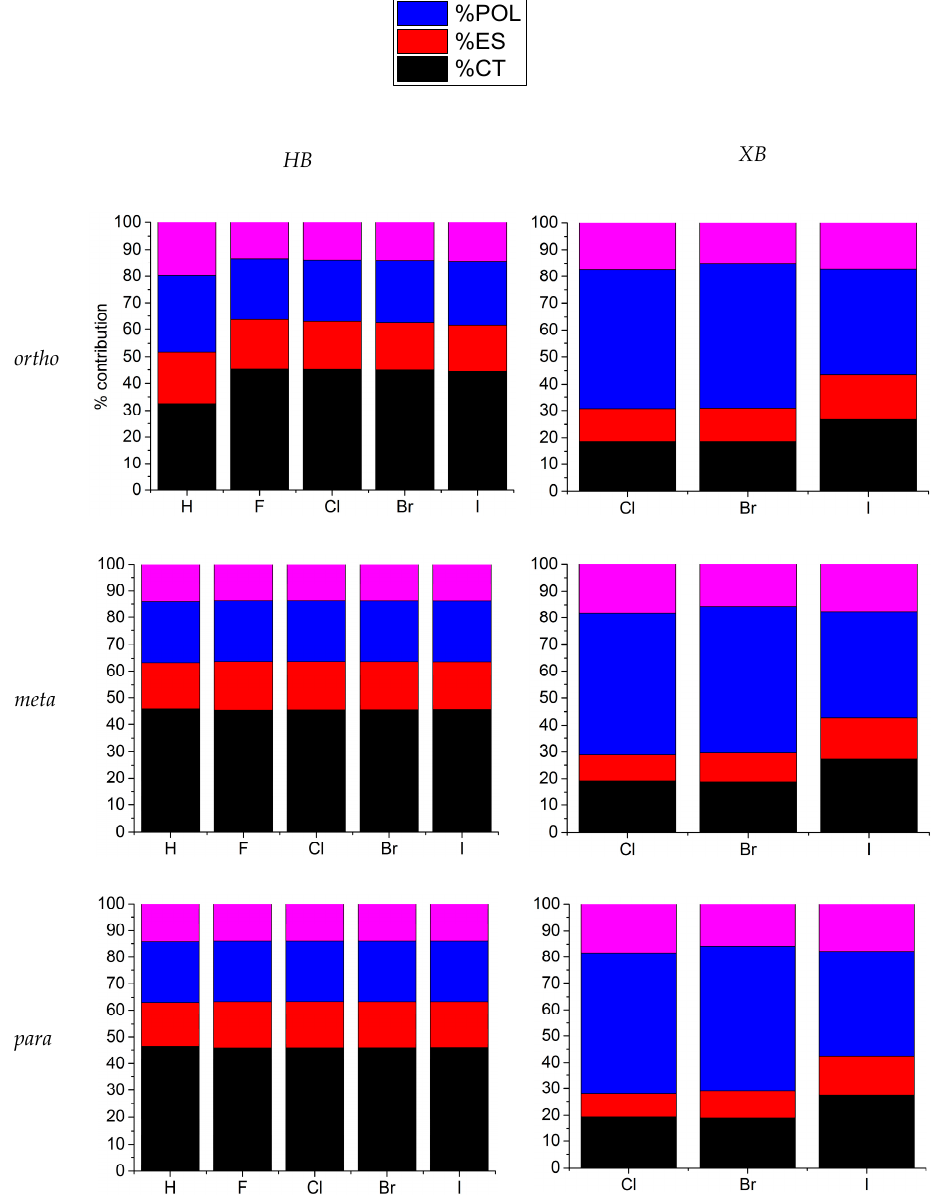
Figure 6. Percentage contribution of the four attractive terms in the NEDA analysis. Magenta, blue, red and black colors correspond to the exchange-correlation, polarization, electrostatic and charge-transfer terms, respectively.